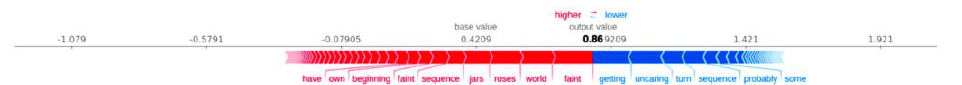
Figure 10. SHAP plot for local explanations of an instance on the CCAT50 dataset.